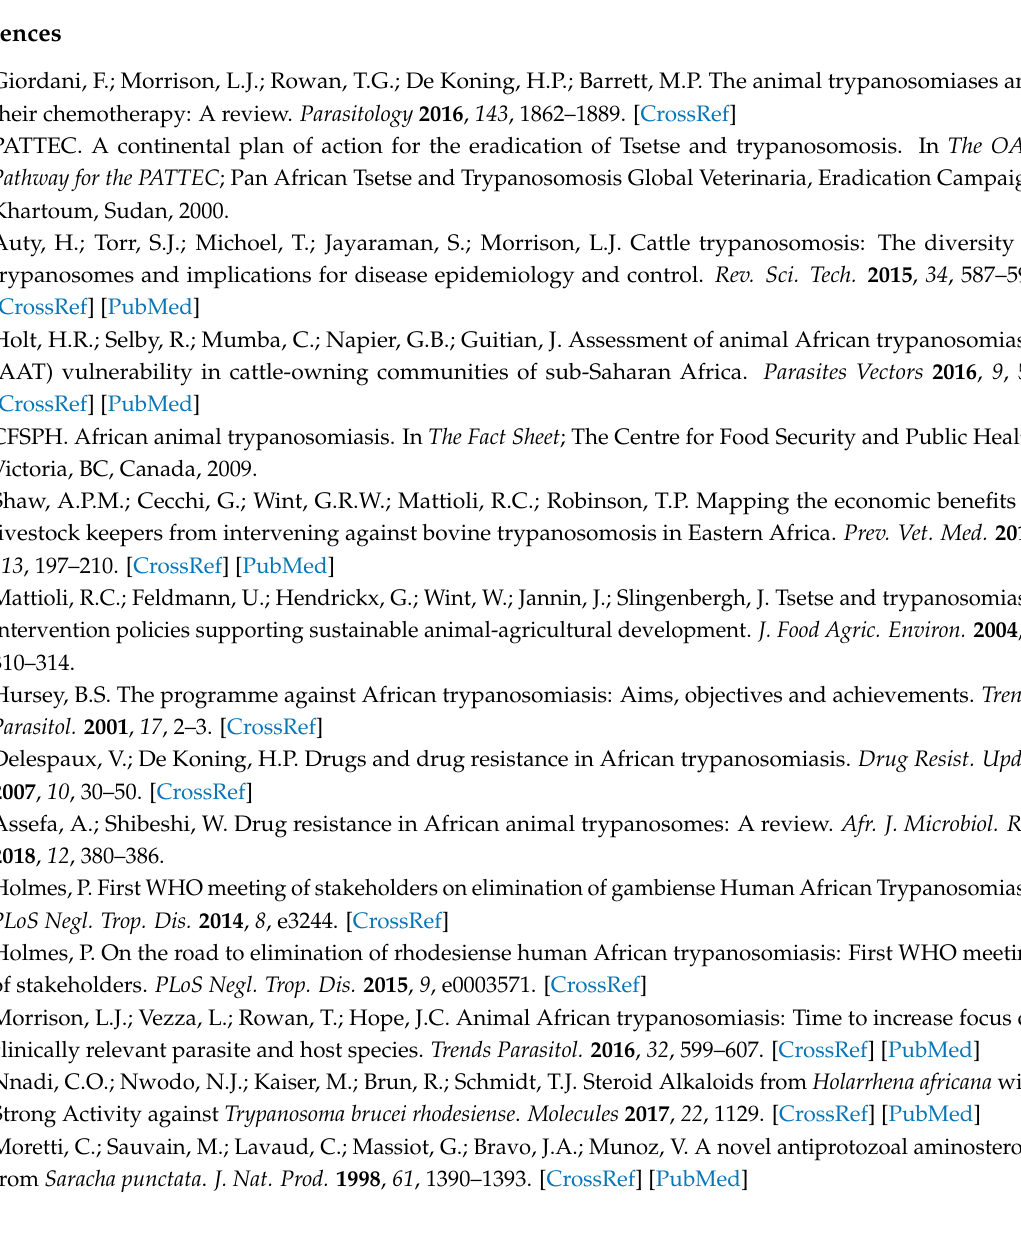
Supplementary Materials: The following are available online. Figure S1: Details of the DNA content and cell cycle